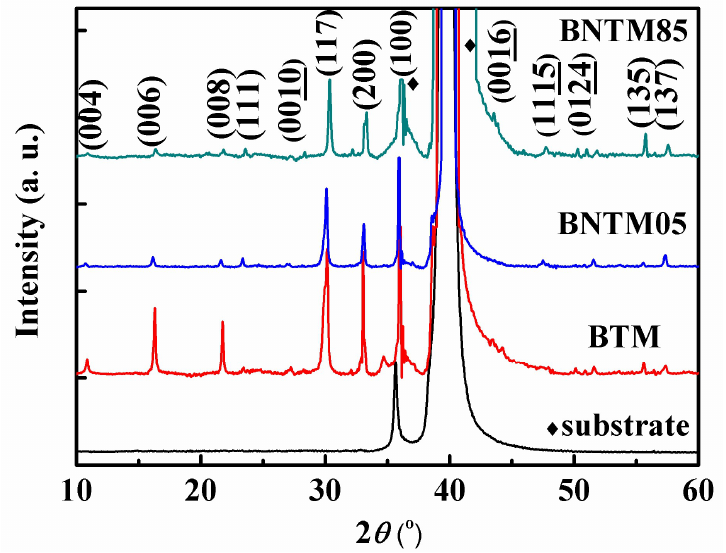
Figure. 1. XRD patterns of substrate, BTM, BNTM05 and BNTM85 thin films.